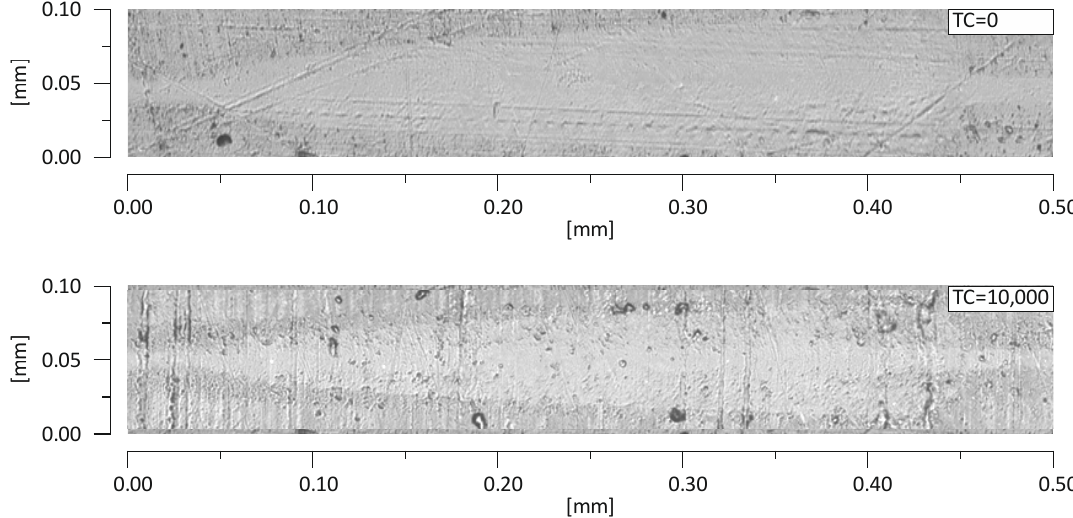
Figure 8. Scratches on the surfaces of the test specimens Z550 with aging only (0 TC) and after thermal fatigue (10,000 TCs).